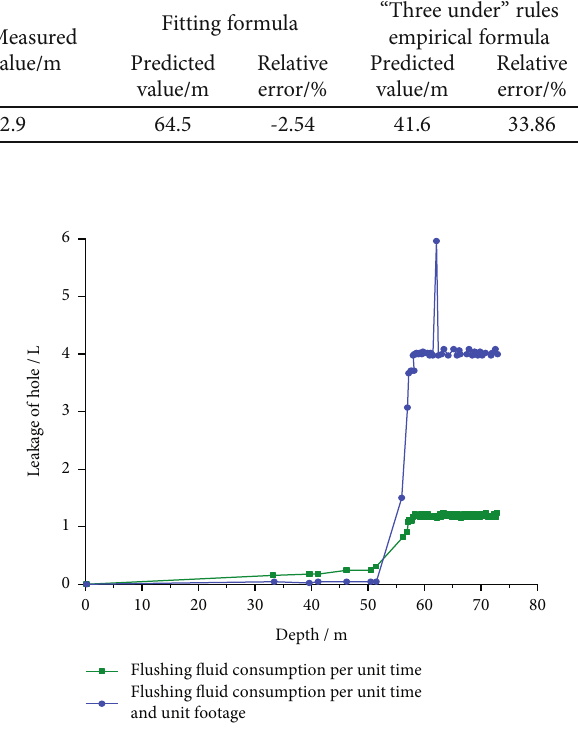
Figure 7: Flushing fl uid consumption curve [33].